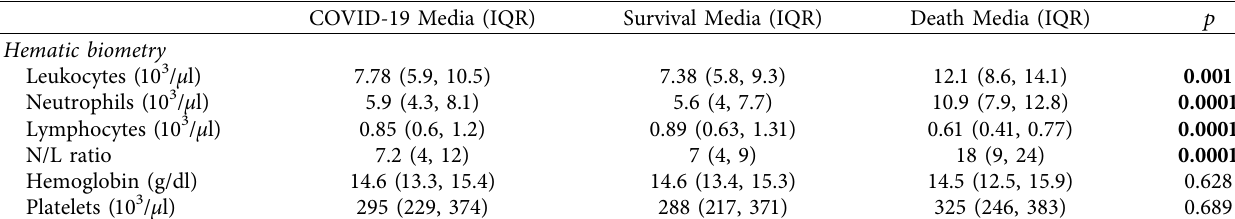
Table 5: Infammatory response, hemoglobin, and platelets levels in hospitalized patients with severe